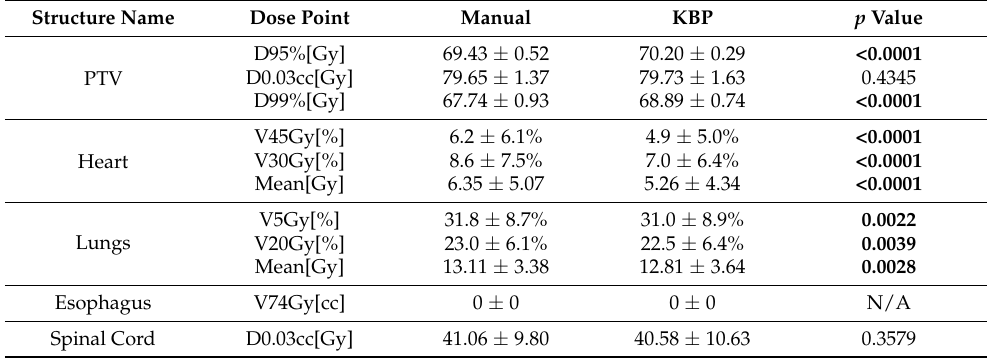
Table 3. Dose comparison and t -test results of 50 manual IMPT plans and 50 KBP plans in the same patients.